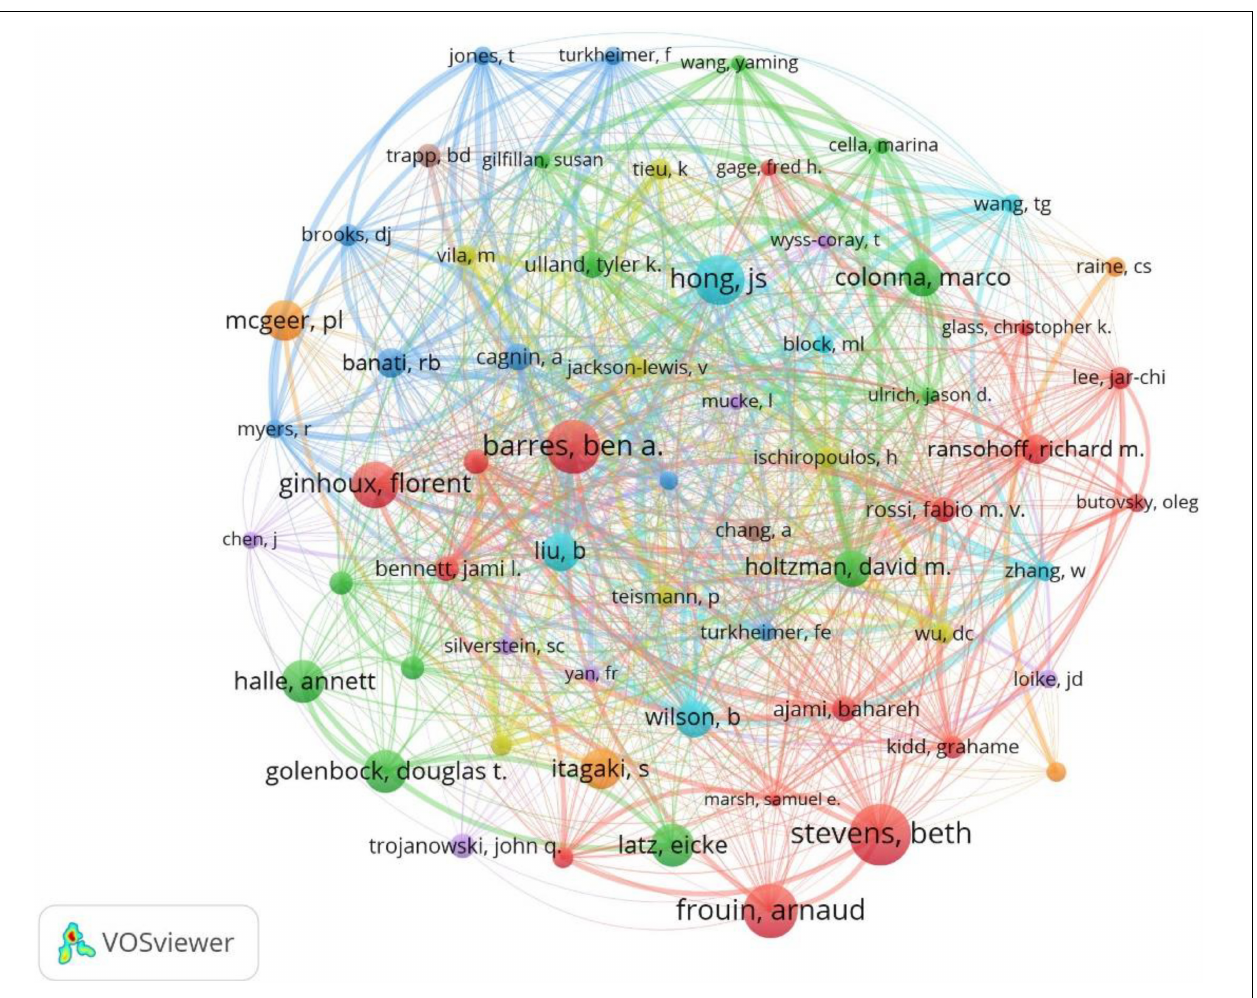
FIGURE 6 | Bibliographic coupling analysis highly cited authors, weighted by citations, visualized map.